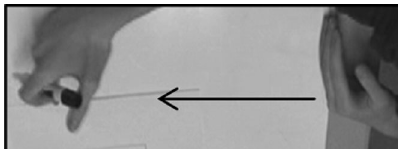
FIG. 16. David’s gesture about ‘‘increasing resistivity.’’